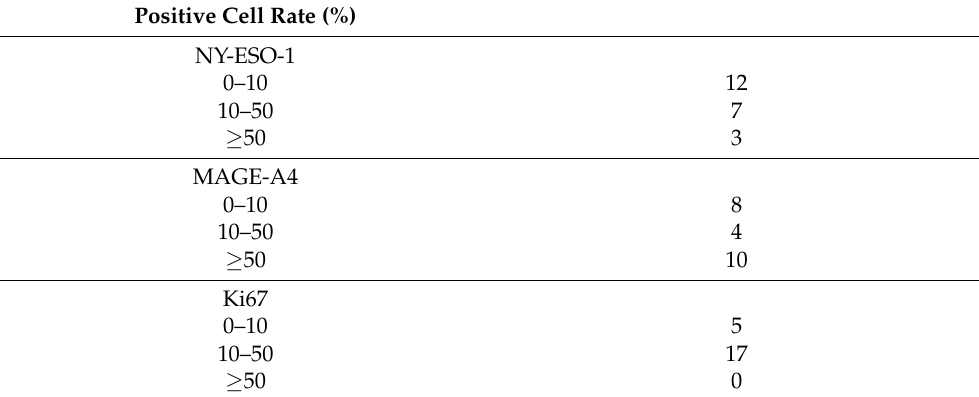
Table 1. Summary of positive cell